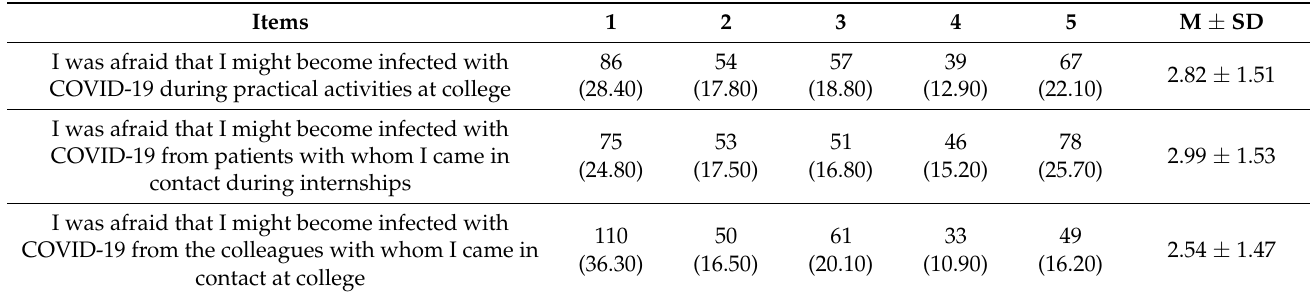
Table 6. Items investigating the fear of COVID-19 infection 1 .